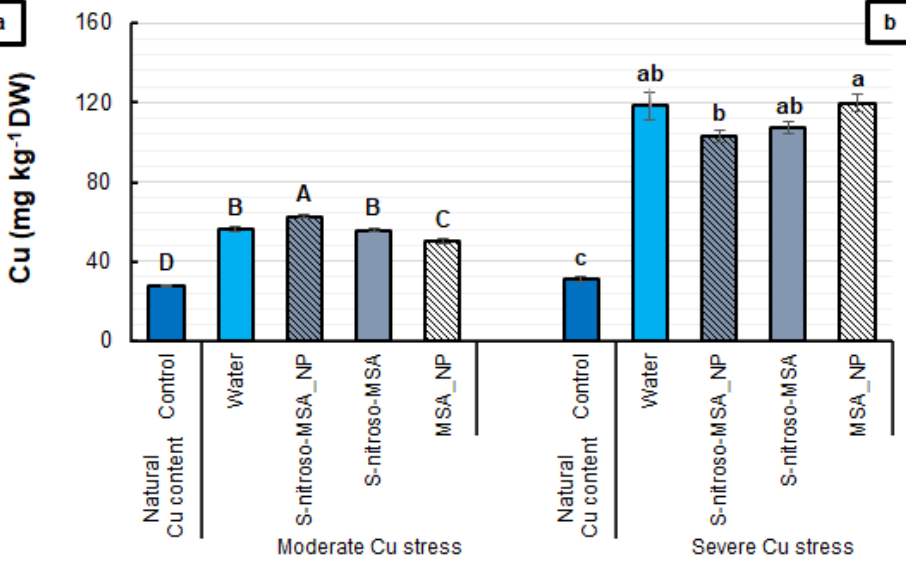
Figure 10. Root Cu content ( a , b ) of soybean plants cultivated in soil containing different copper (Cu) levels (natural content: 11 mg kg − 1 ; moderate Cu stress: 164 mg kg − 1 ; severe Cu stress: 244 mg kg − 1 ). Control = treatment with distilled water; water = treatment with distilled water after Cu addition; S-nitroso-MSA_NP = treatment with a nanoencapsulated NO donor (S-nitroso-mercaptosuccinic acid) at 1 mM; S-nitroso-MSA = treatment with a NO donor (S-nitroso-mercaptosuccinic acid) in the free form at 1 mM; MSA_NP = treatment with nanoparticles containing the non-nitrosated MSA at 1 mM. Data are the mean ± standard error ( n = 4). The same uppercase and lowercase letters on the column (referring to experiments 1 and 2, respectively) indicate values that do not differ by ANOVA, followed by the Tukey test ( p < 0.05).